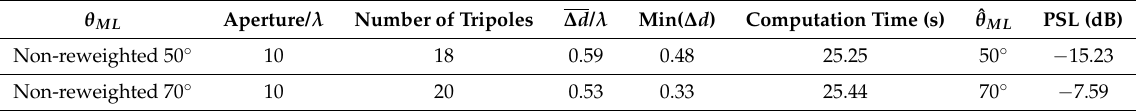
Table 5. Off-broadside performance comparison, for α = 0.95.